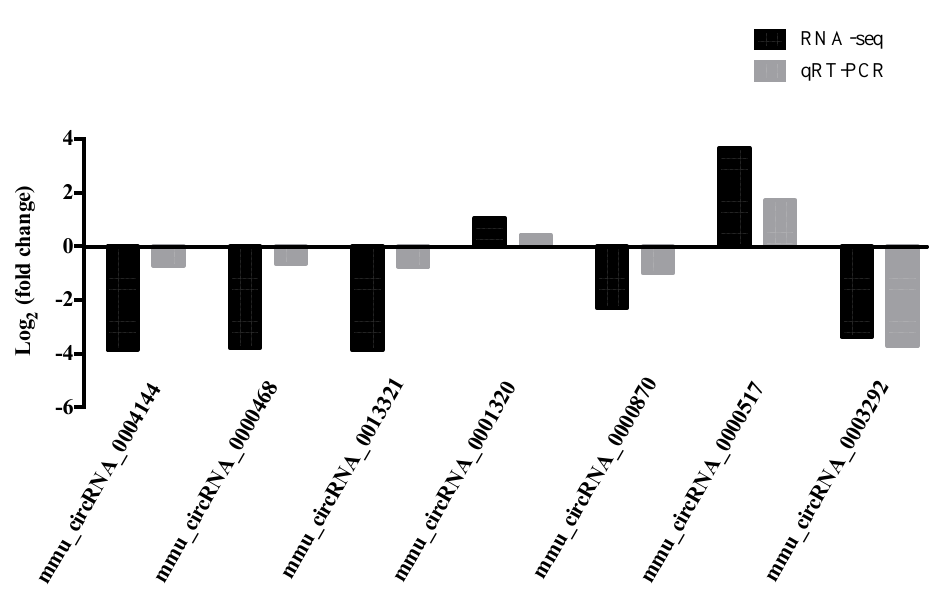
Figure 5. Quantitative real-time PCR validation of the selected circRNAs.